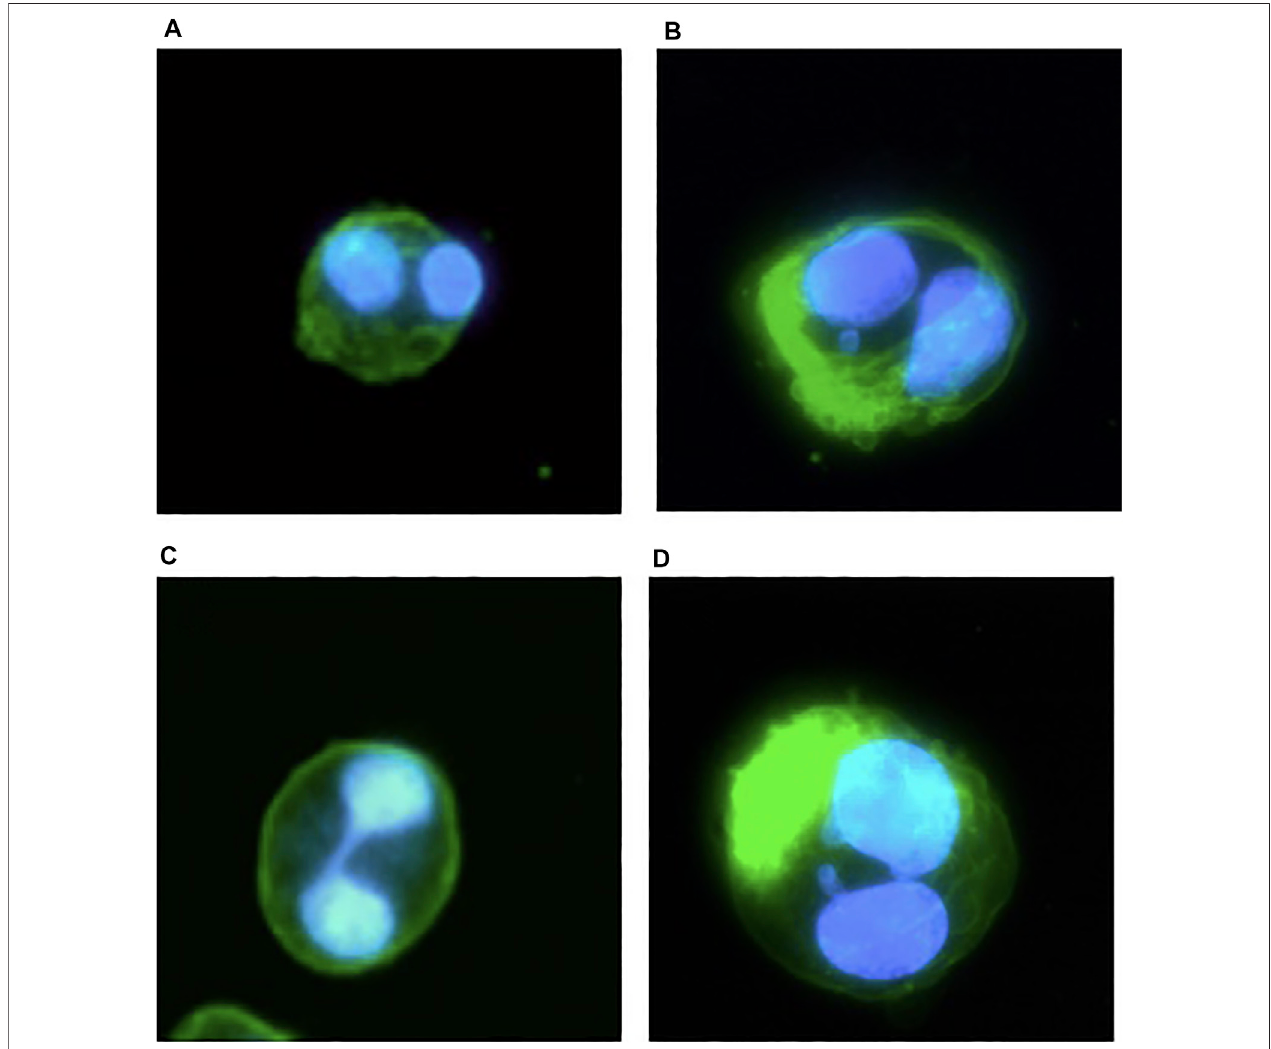
FIGURE 2 | An illustrative example of CHO-S suspension cell microscope images after the CBMN assay taken from the pilot studies and assay protocol validation experiments; blue represents DAPI fl uorescent dye staining ofthecell DNA forthe detection ofDNA abnormalitiesofBN cells: (A) normal BNcells; (B) BNcells withMN; (C) BN cells with NBridge; (D) BN cells with